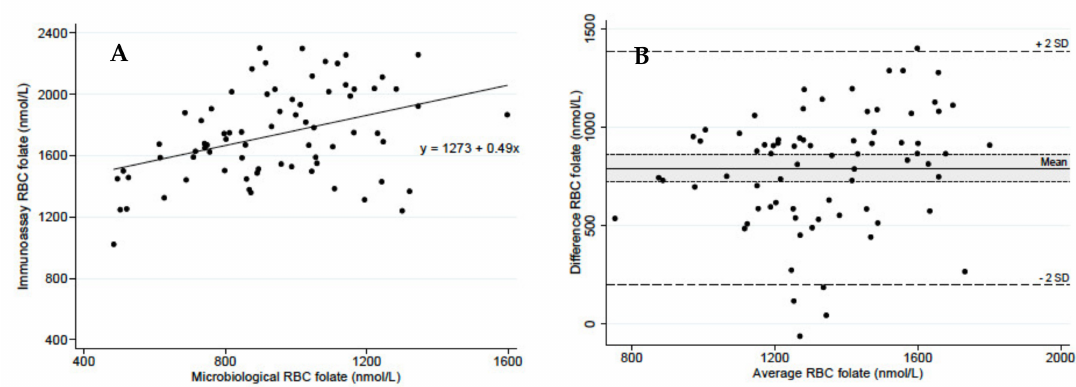
Figure 1. Comparison of red blood cell folate concentrations measured in concurrent venous blood samples using microbiological [chloramphenicol-resistant L. rhamnosus (ATCC 27773 or NCIB 10463) assay and erythrocyte folate measured by the protein-binding assay (Roche Modular E 801 Immunology Analyzer) ( A ) by regression; ( B ) and by a Bland–Altman Plot (di ff erence on the y-axis is the immunoassay – microbiological RBC folate concentrations, with the shaded area corresponding to a 95% confidence interval for the mean di ff